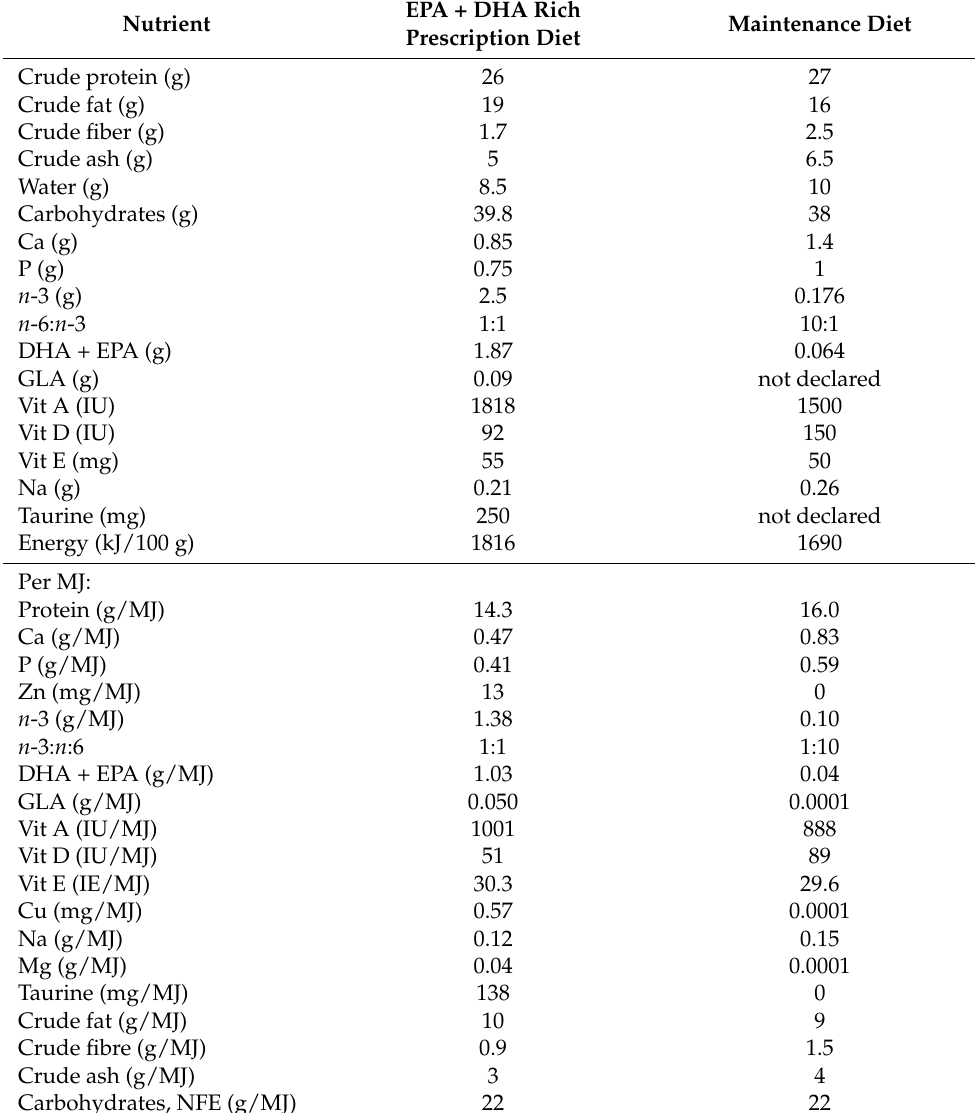
Table 2. Composition of dry diets—analysis per 100 g. Test performed in Hamiton Poland Laboratory.